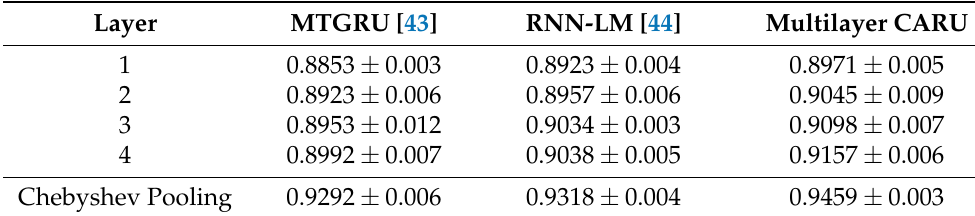
Table 2. Average accuracy of IMDB test data with the error range.